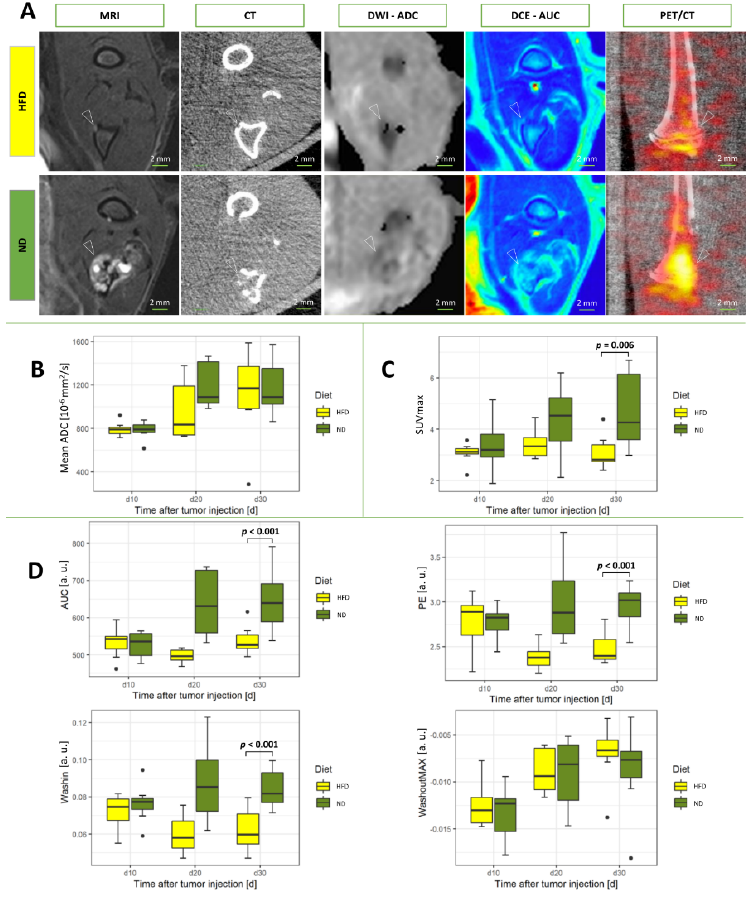
Figure 3. Functional and metabolic parameters of the control experiment in high fat and normal diet rats under inhibition of the PPAR γ pathway with BADGE: ( A ) Representative images for day 30 of multiparametric MRI and PET/CT for both diet regimes under BADGE treatment ( B ) Apparent dif- fusion coefficient (ADC) of the diffusion-weighted imaging. ( C ) Standardized uptake value (SUV) of the positron emission tomography (PET). ( D ) Calculated parameters for the quantitative model of the signal curve of the dynamic contrast-enhanced (DCE) MR perfusion for BADGE experiment. White arrows indicate location of the bone metastases. Abbreviation a.u. stands for arbitrary units. Statistical analyses were performed with two-way ANOVA and Mann-Whitney-Wilcoxon U test. Significant values are defined as p < 0.05. Values of p are indicated up to a value of 0.15. Functional MR imaging using intravenous contrast (DCE-MRI) resulted in signifi- cantly decreased parameters area under the curve (AUC), wash-in (WI), and peak en- hancement (PE) in rats from the HFD group (all p -values p < 0.001, respectively), while the parameter wash-out (WO) was not significantly different between animals of the HFD and ND groups ( p = 0.34; Figure 2).